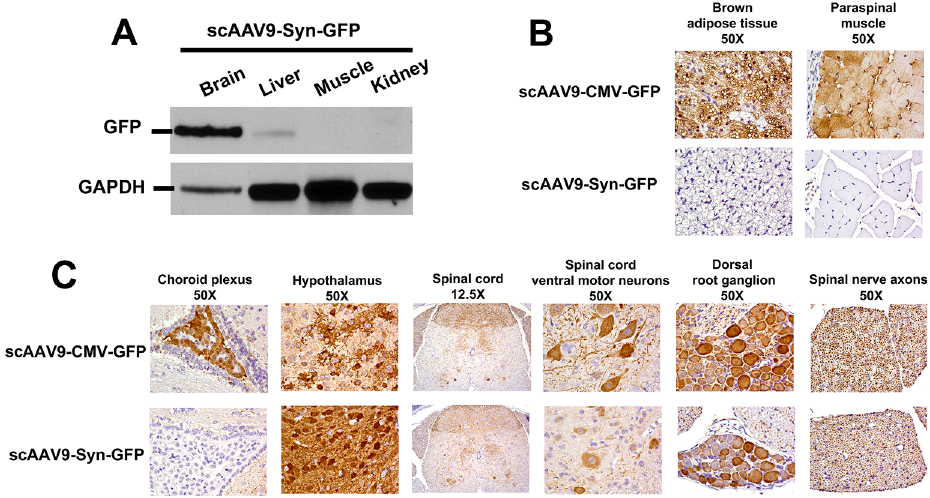
Fig 3. Nudt7cyt and CoA levels in brains of animals injected with scAAV9-Syn-Nudt7cyt. (A) Nudt7 mRNA levels in mice injected with scAAV9-Syn- Nudt7cyt or scAAV9-Syn-GFP as normalized to GAPDH. AAV particles were injected as described in ‘ Materials and Methods. ’ (B) Overexpression of Nudt7cyt was confirmed by western blot analysis (inset) and measurement of CoA-degrading activity in brain homogenates. (C) Brain CoA was measured in 5 – 17 week-old mice, as indicated, injected with scAAV9-Syn-Nudt7cyt or AAV9-Syn-GFP as described in ‘ Material and Methods ’ . Numbers in parenthesis indicate the total number of animals used for the measurements. Data are reported as the mean ± the standard error. * , p < 0.05; ** , p < 0.01; *** , p < 0.001.